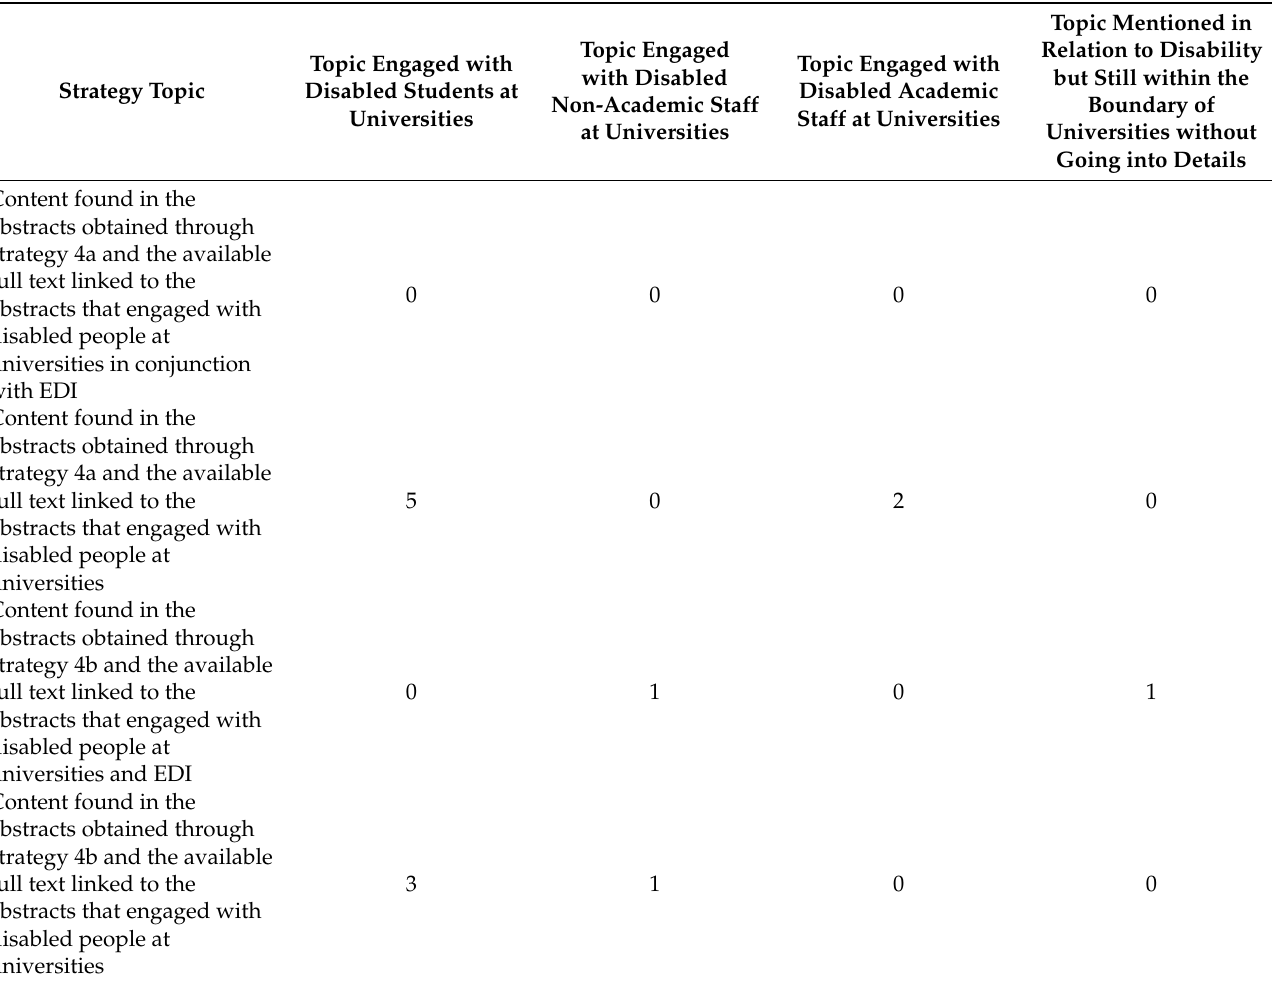
Table 3. Frequency of relevant topics engaging different groups of disabled people (strategy